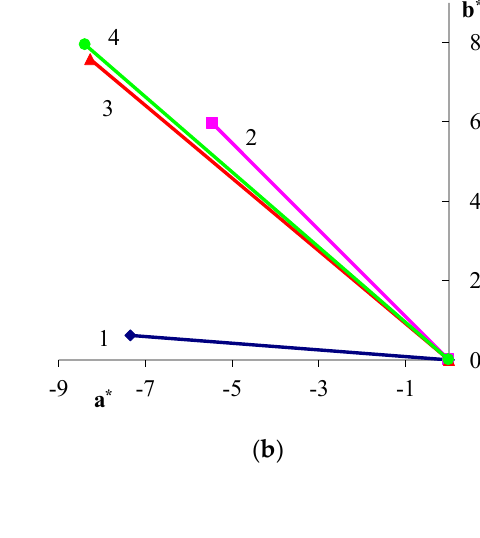
vector projection shows it clearly.